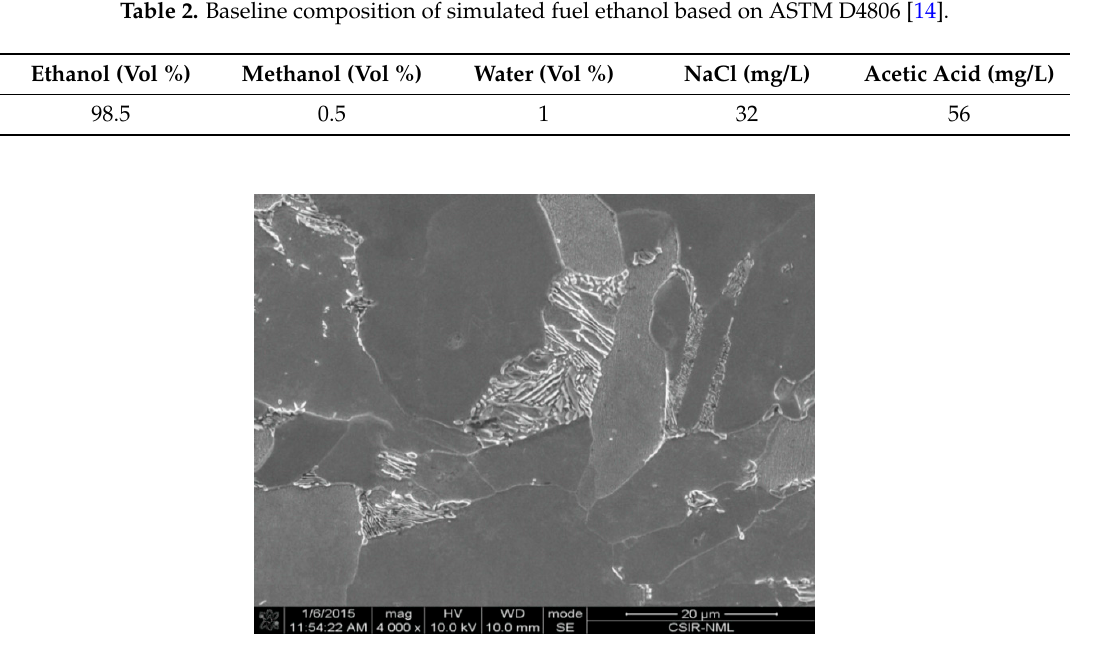
Figure 1. Typical microstructure of MAS in as-received condition showing the presence of ferrite ( dark ) and pearlite ( white ) phases at magnification of 4000×.